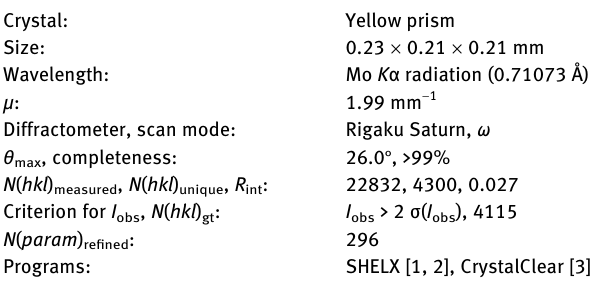
Table  : Data collection and